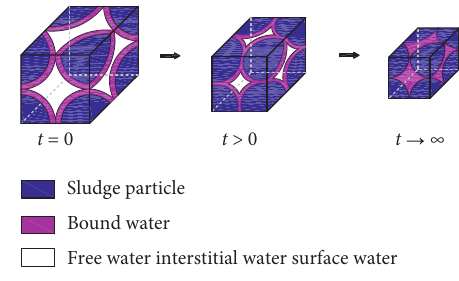
Figure 2: The process of sludge